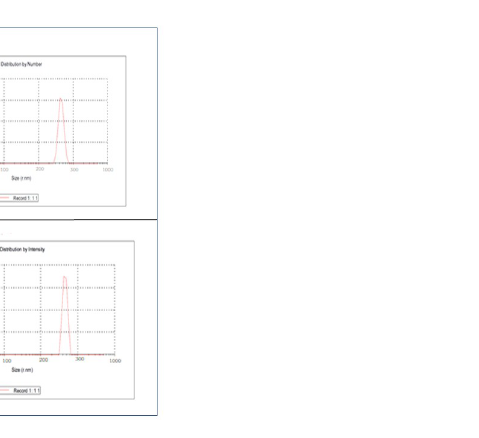
Fig 1. Identification and characterization of GNPs at pH